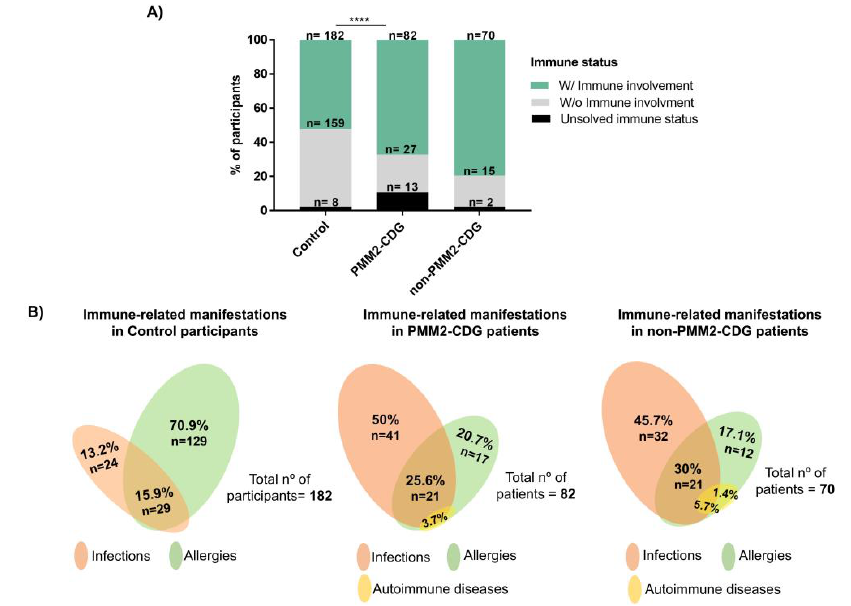
Figure 2. Prevalence and types of immune-related clinical features. ( A ) Overall immunological involvement. Three categories based on the immune manifestations reported were established.